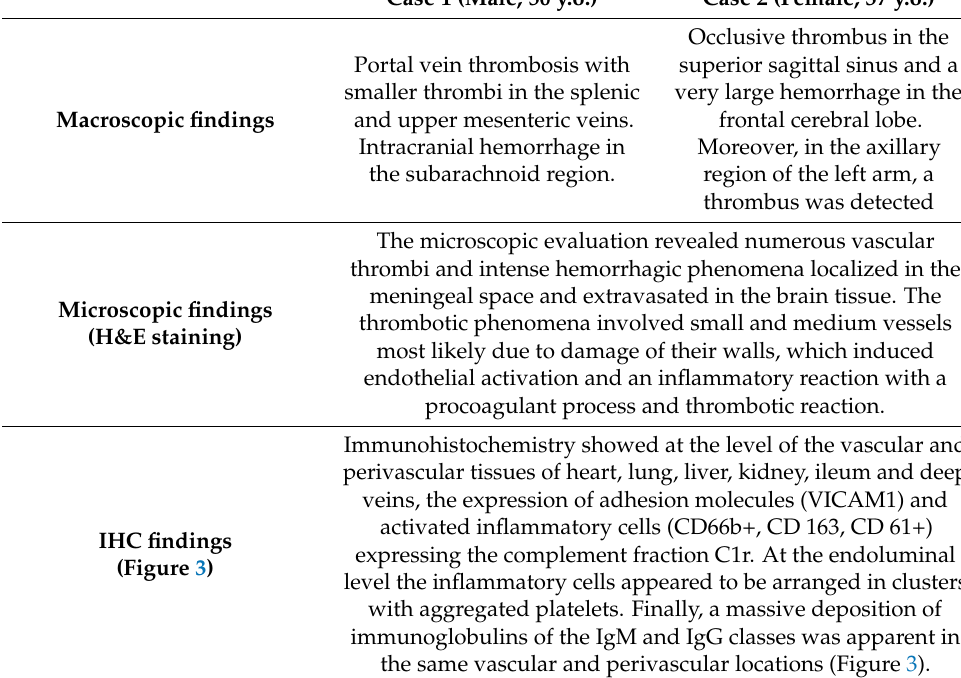
Figure 3. IHC in the exemplificative cases of VITT demonstrated the activation of the innate immunity and of the complement pathway at the level of vascular and perivascular tissues of the major organs. ( A ) lung stained for the complement fraction C1r (20 × ); ( B ) Cephalic vein with deep vein thrombosis stained for the complement fraction C4d (10 × ); ( C ) liver positive for CD 163 cells infiltrates (20 × ); ( D ) clusters of activated CD66 cells in the lung (20 × ). Table 3. Main findings of post-mortem examination. Case 1 (Male, 50 y.o.) Case 2 (Female, 37